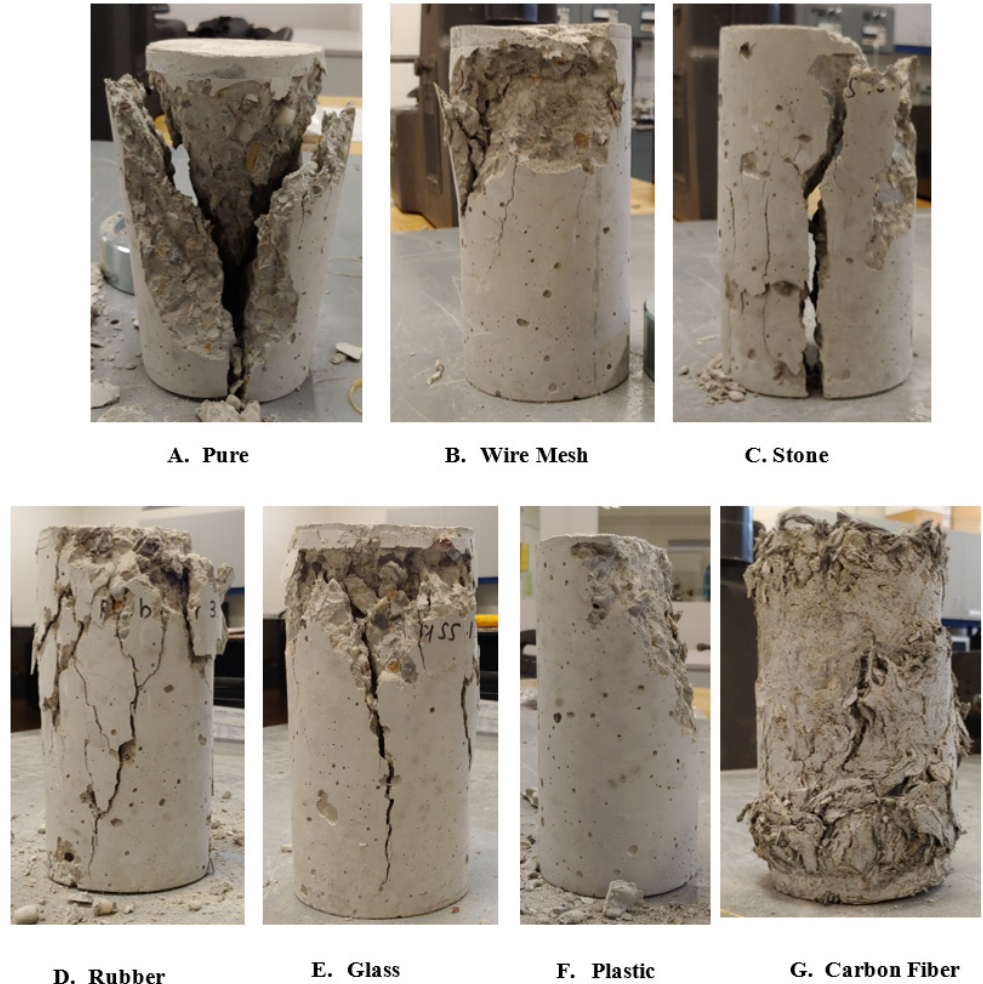
J. Compos. Sci. 2023 , 7 , x FOR PEER REVIEW Figure 2. Types of failures observed after compression testing of reinforced concrete cylinders.